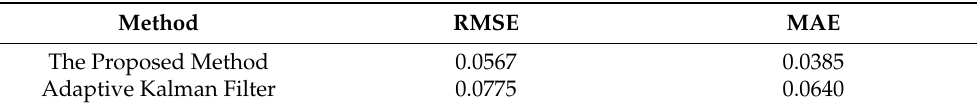
Figure 13. RUL prediction results for different methods. Table 8. Comparison with other authors’ methods.